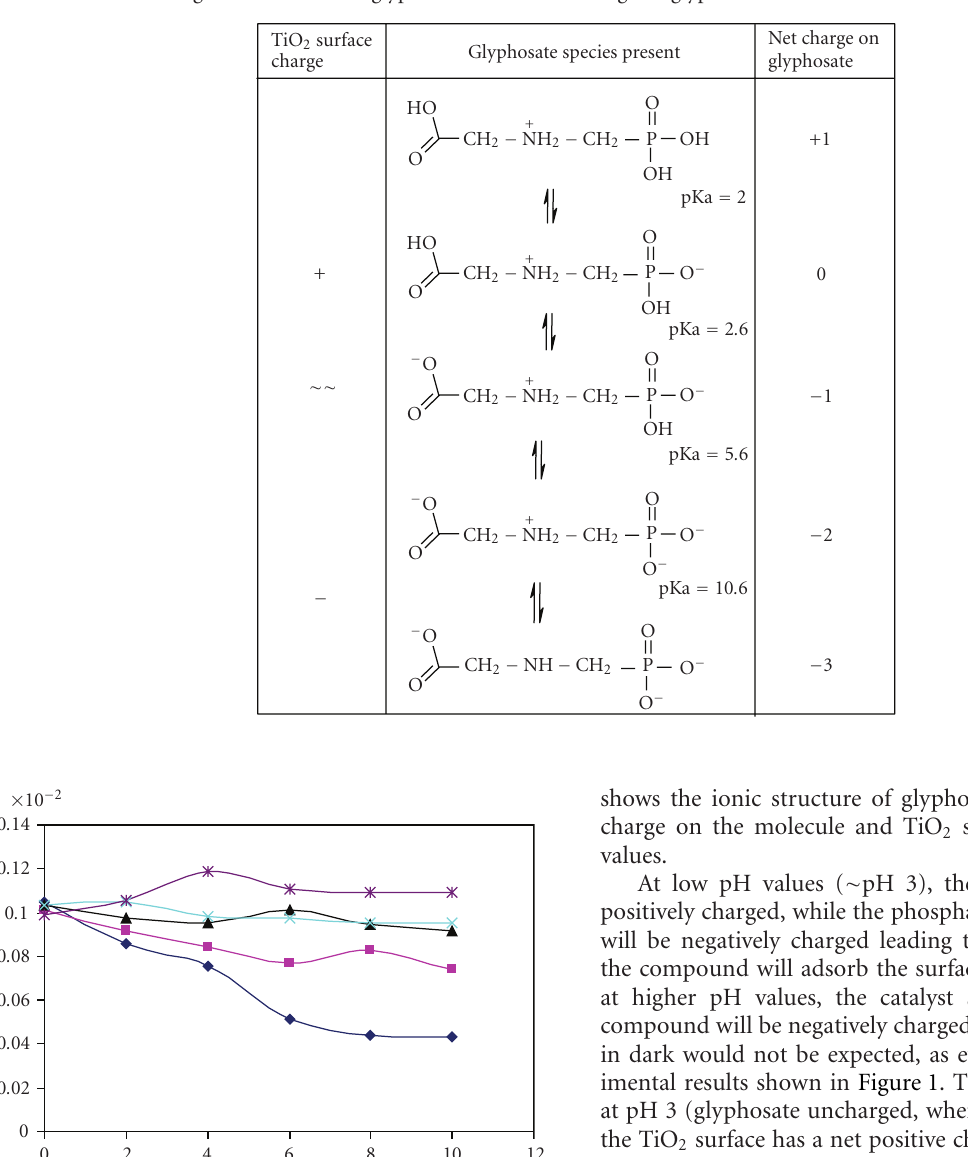
Table 1: Table showing di ff erent forms of glyphosate and the net charge on glyphosate and the surface of TiO 2 as a function of pH.